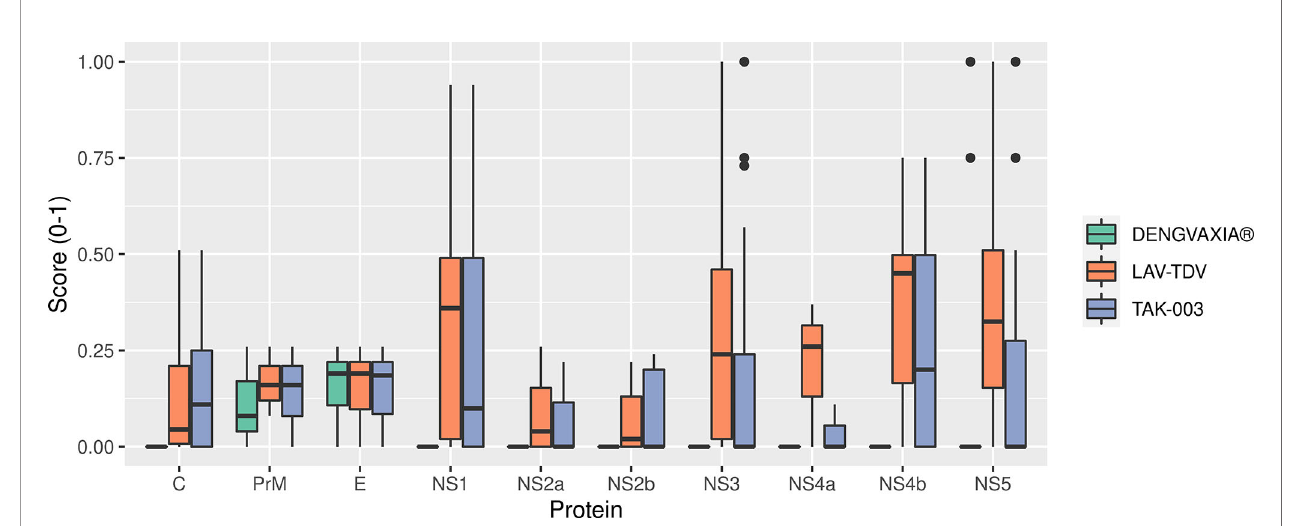
FIGURE 3 | Distribution of protein scores in the three